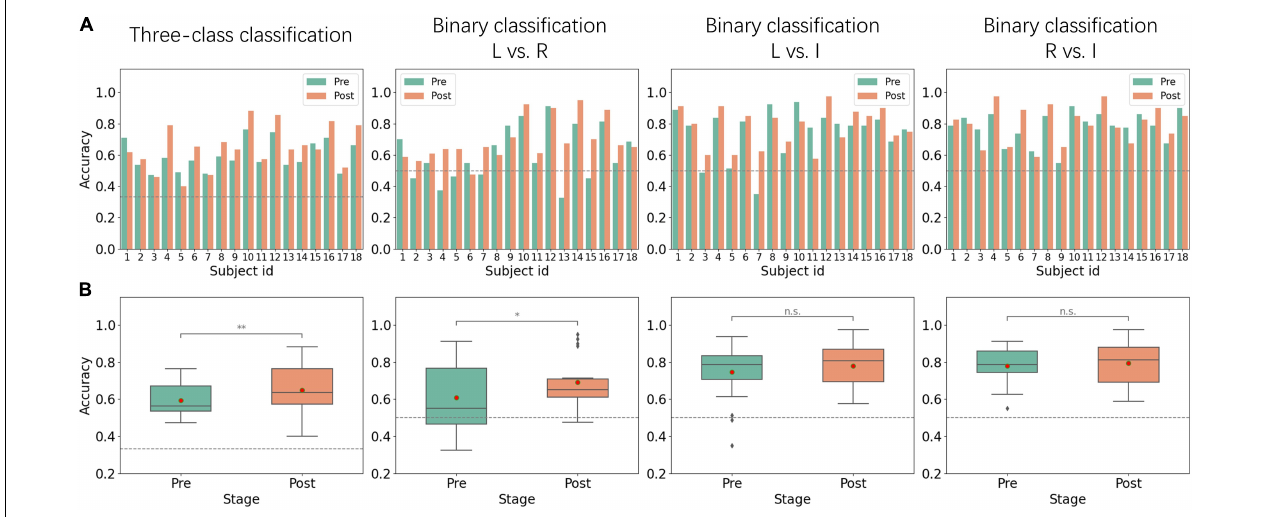
FIGURE 3 | Performance from pre-NFT (Pre) and post-NFT (Post) MI sessions. (A) Histogram of inter-subject classification accuracy – the dotted gray line represents the random levels of 33.33 and 50%. (B) Boxplots of classification accuracy - the red dot represents the average value: L vs. R, left-hand MI versus right-hand MI; L vs. I, left-hand MI versus idle task; R vs. I, right-hand MI versus idle task; ∗ p < 0.05; ∗∗ p < 0.01; n.s., no